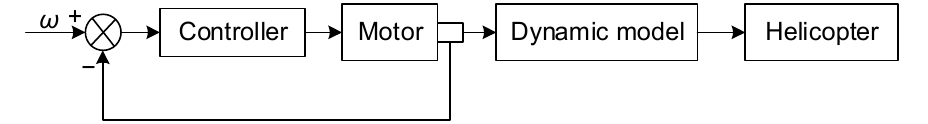
Figure 15. Schematic diagram of the simulation model.